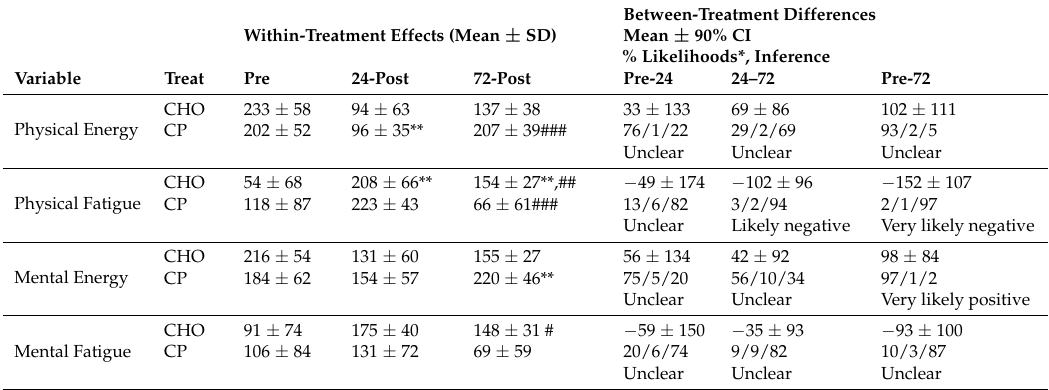
Table 3. Muscle Soreness Ratings (Ascending Stairs) with Protein Supplementation